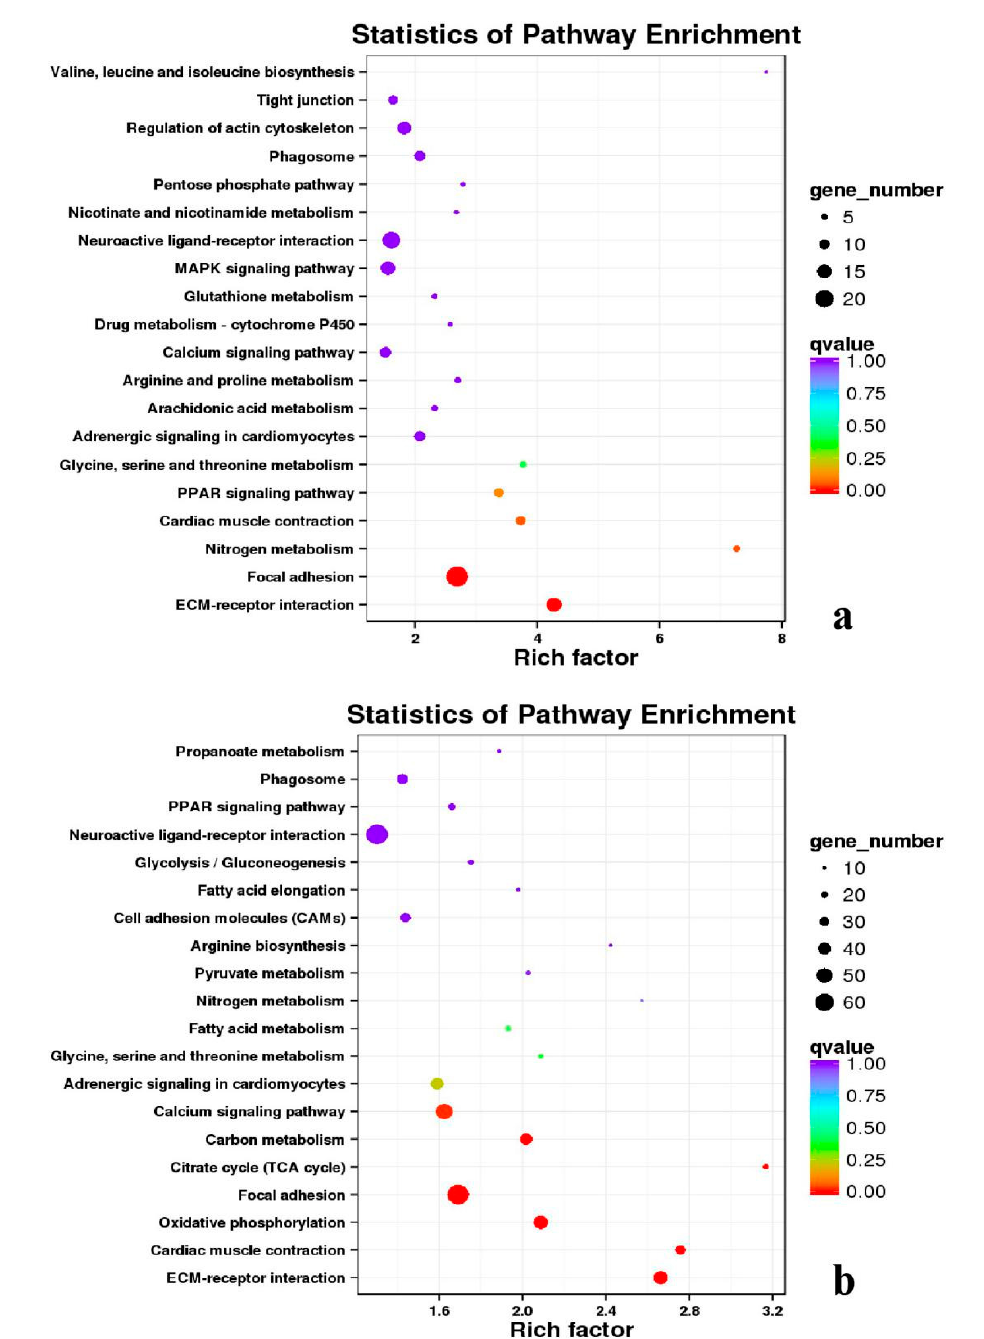
Figure 15. KEGG annotation of DEGs in leg muscle. ( a ) BE17L_vs_BE21L; ( b ) BE17L_vs_BE27L.